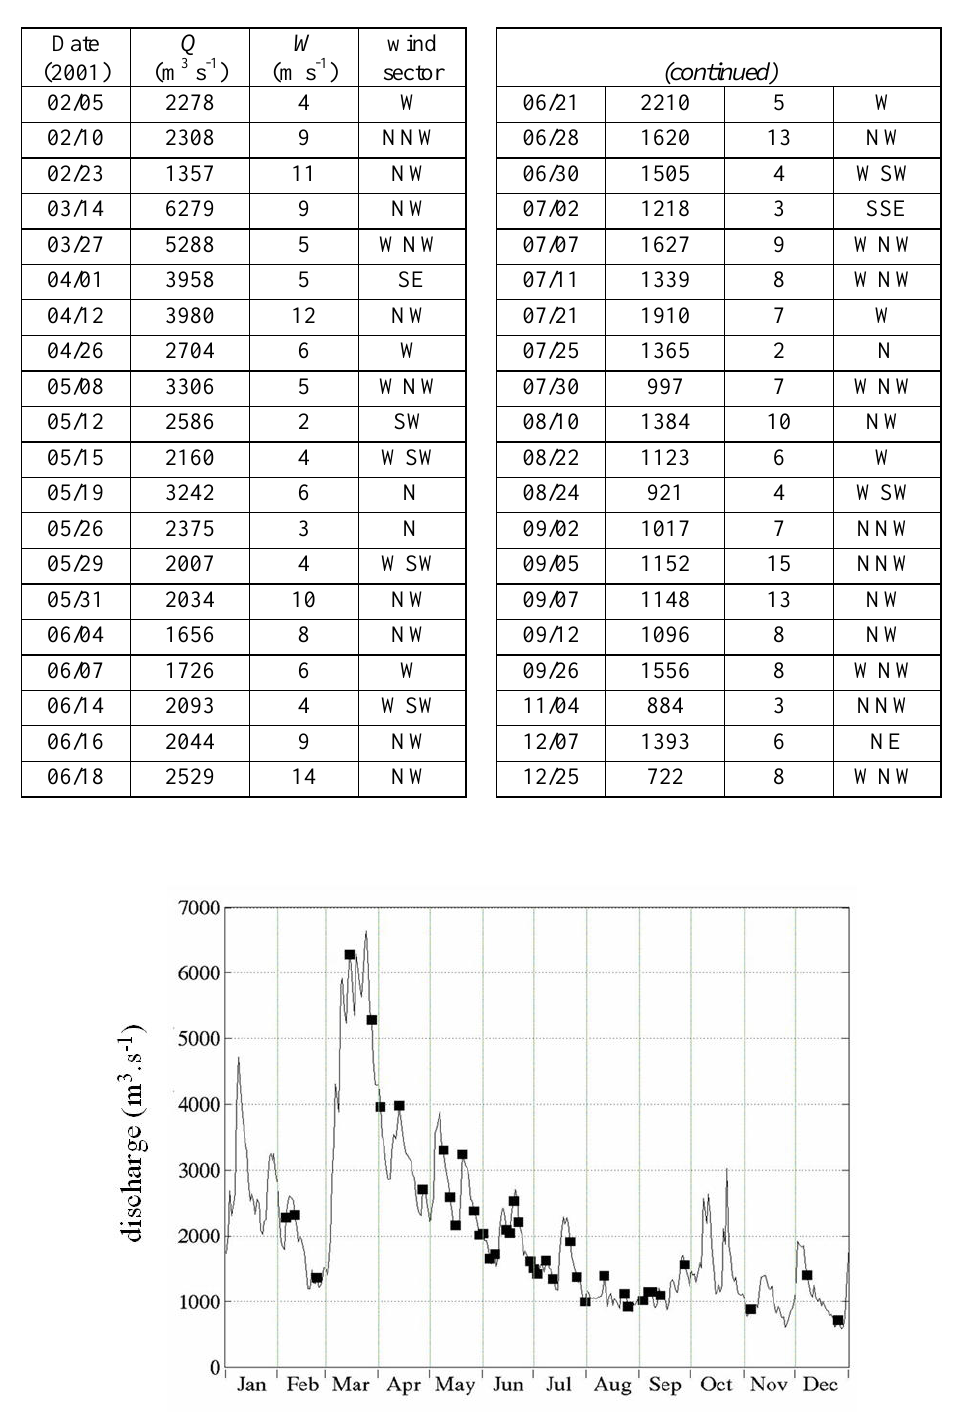
Table 1. List of the SeaWiFS images considered and associated Rhône discharge value, Q , and typical wind speed, W , and wind sector (the sector from which the wind is blowing). The typical wind of an image is the wind of maximum velocity within a zone defined by 4°W-5°W;42.7°-43.2°N.